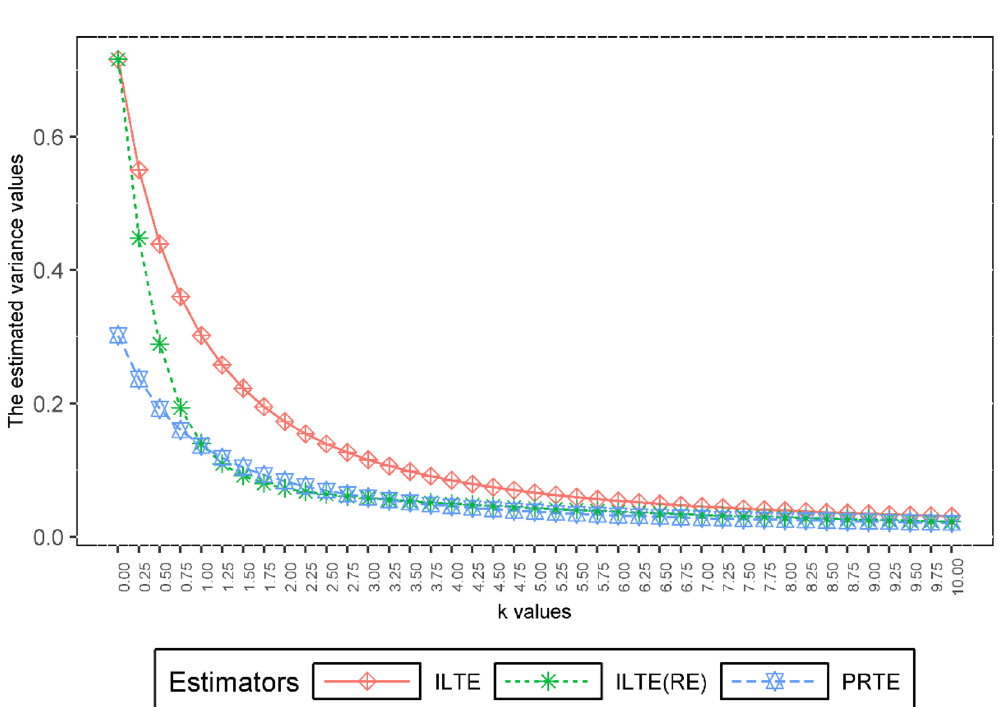
Figure 4. The estimated variance values of ILTE, ILTE(PRE) and PRTE as a function of k